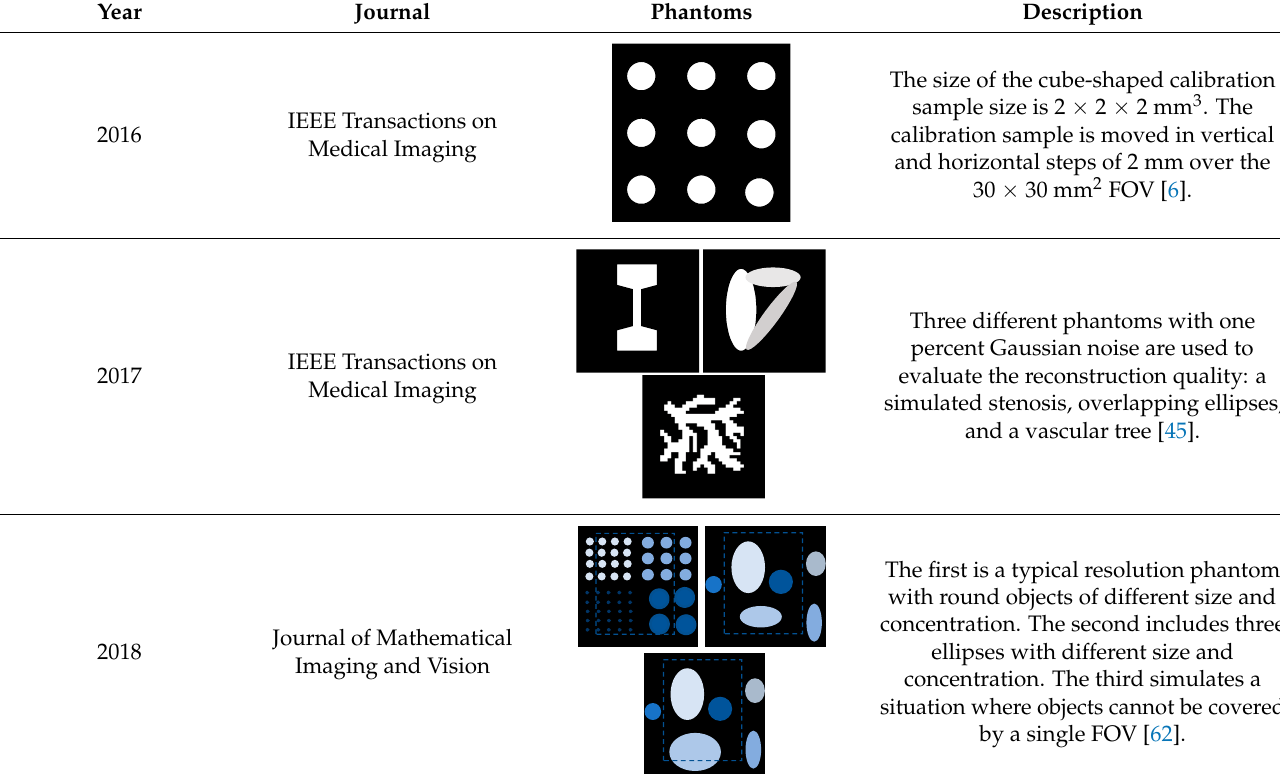
Table 1. Different phantoms used for MPI reconstruction.